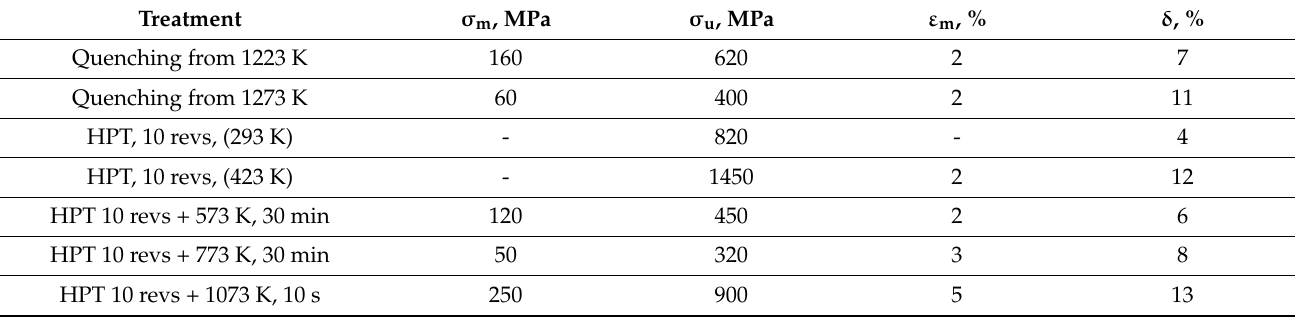
Table 6. Tensile test results of the Cu–14Al–3Ni alloy after different deformation and heat treat- ments.